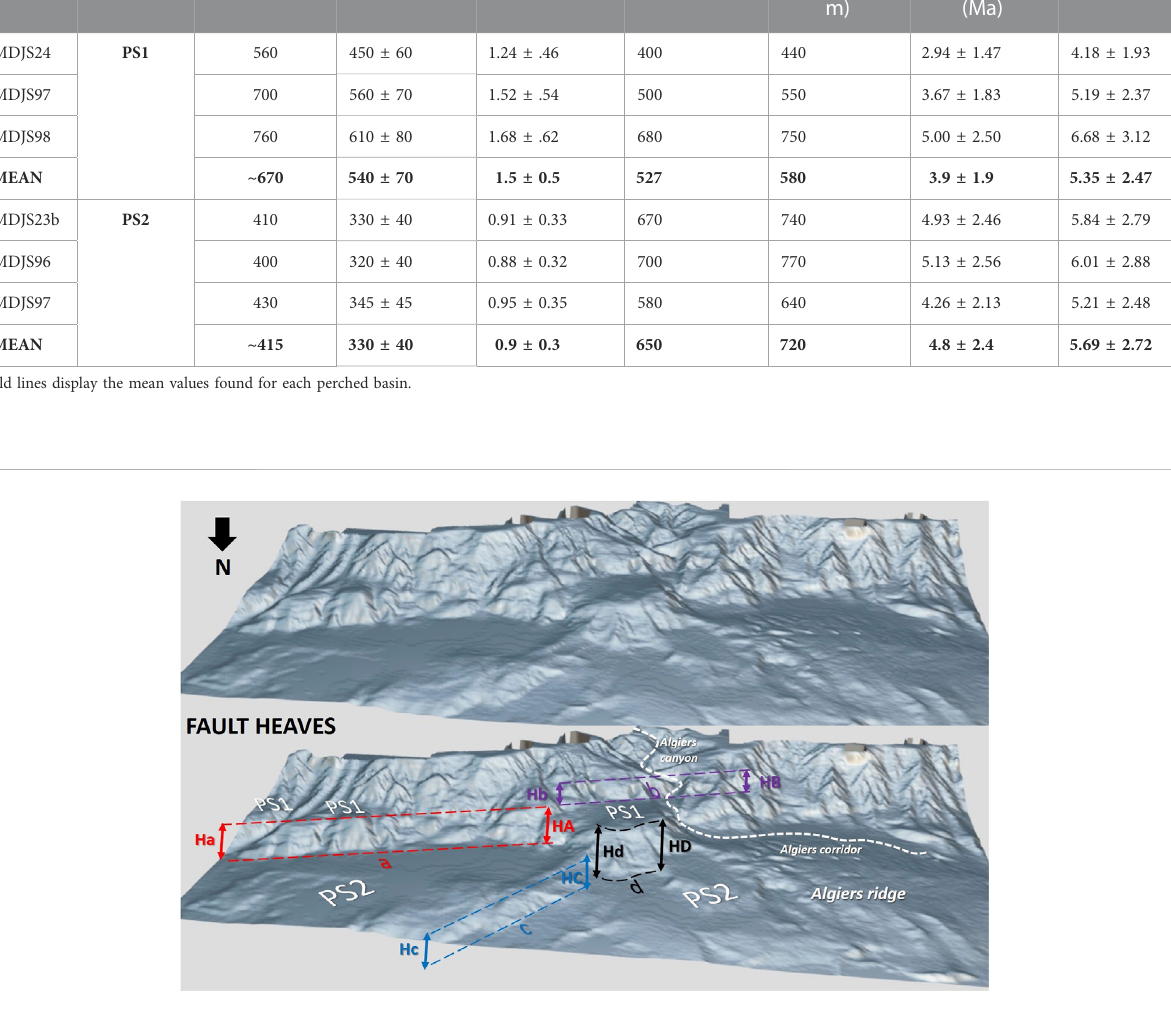
FIGURE 10 Perspectiveview towards thesouth oftheboumerdès slope and basinina “ MatCap ” geometryplot(https://sketchfab.com/3d-models/marge- boumerdes-e160112567d745bdb5e80d9f7dd1a64c) displaying the main cumulative scarps identi fi ed off Boumerdès. Bottom fi gure provides our interpretation of fault heaves Ha-HA and Hb-HB for Fault F1 (Fe1 and Fo1, respectively), and Hc-HC and Hd-HD for Fault F2 (Fe2 and Fo2, respectively). PS1 and PS2 refer to the perched surfaces mapped on Figure 2. Assumed faults F1 and F2 are shown on Figure 7; Figure 11. Measured values are reported in Table